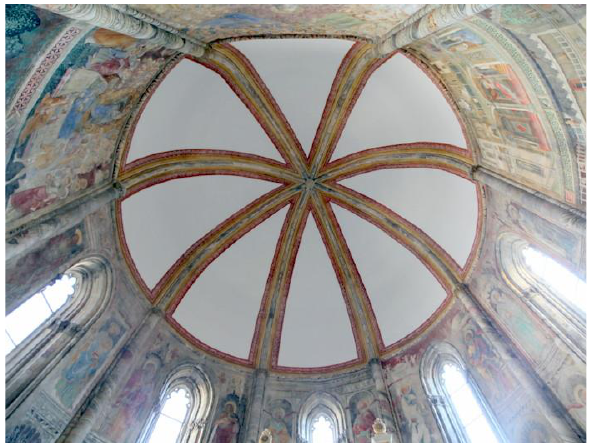
Figure 5. Naples, San Giovanni a Carbonara Church. The ribbed calotte of the Caracciolo del Sole